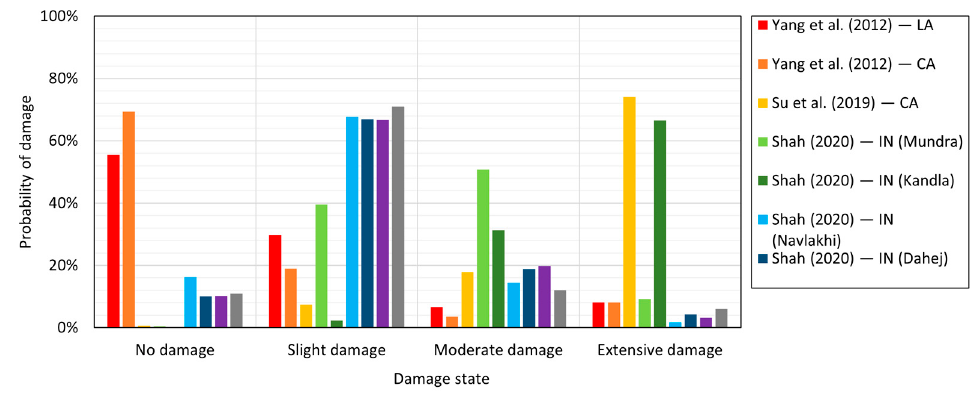
Figure 11. Comparison of damages on wharf structure based on a selected scenario earthquake. LA: Los Angeles, CA: California, IN: India, GT: Gioia